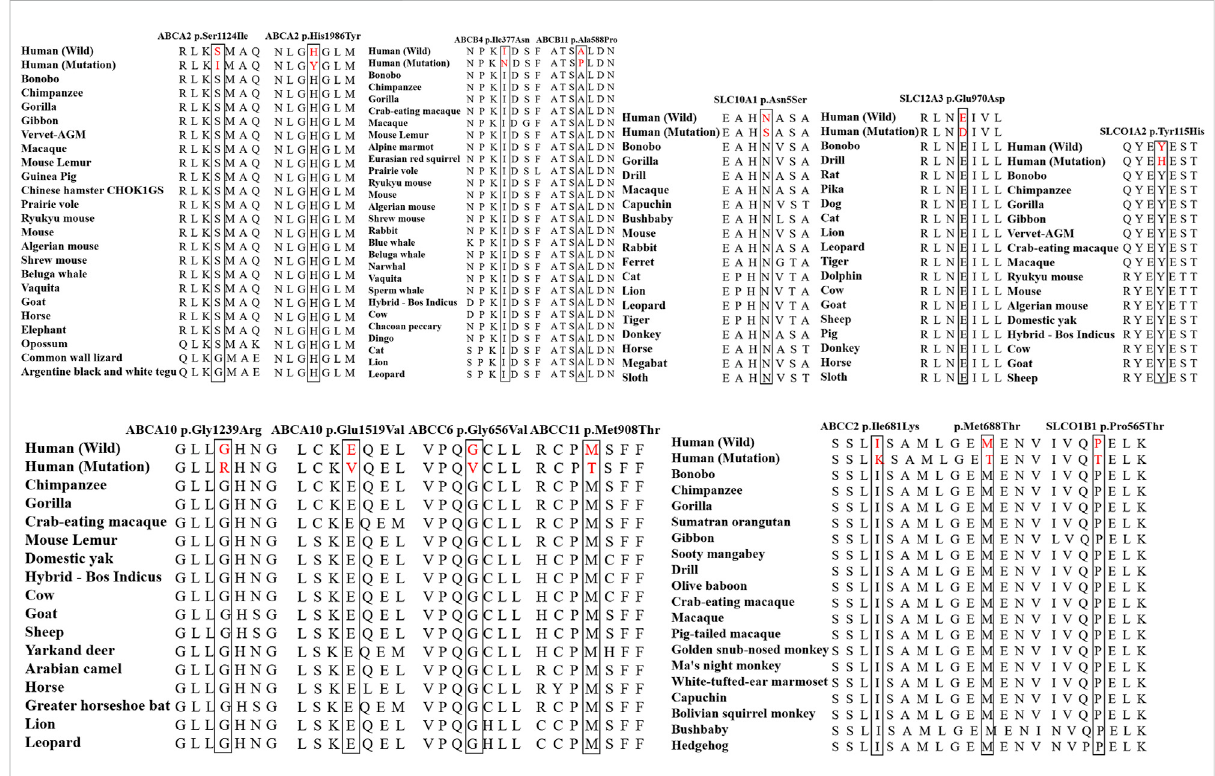
FIGURE 3 The evolutionary conservation analysis of the mutations in the damaging group among vertebrates, including chimpanzees, gorillas, rats, dogs, pigs, and cows. The amino acids in the red horizontal line were highly